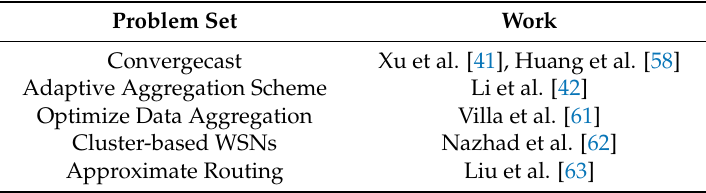
Table 1. The references summary of research on data aggregation